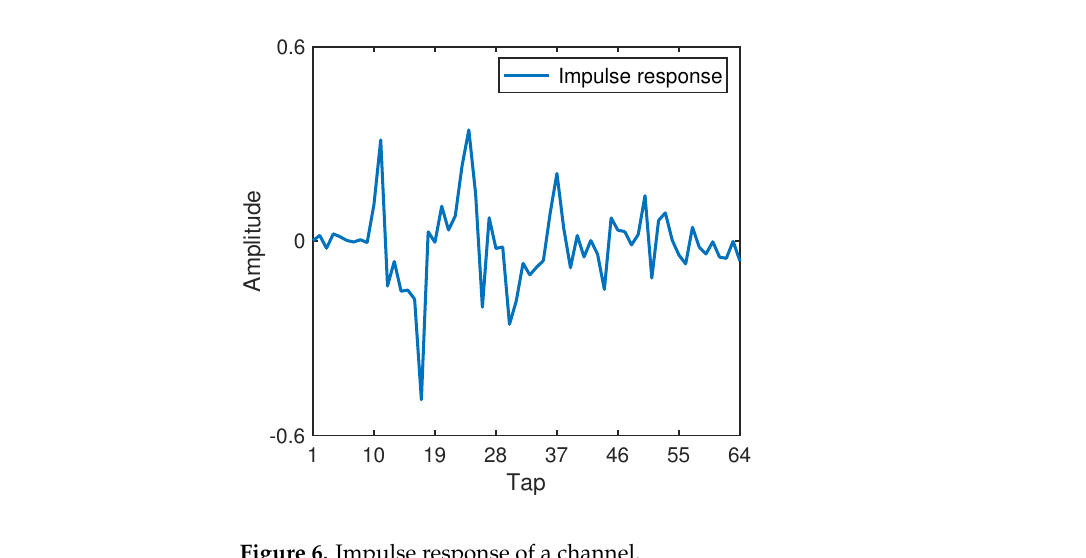
Figure 6. Impulse response of a channel. Table 1. Parameters of simulations and